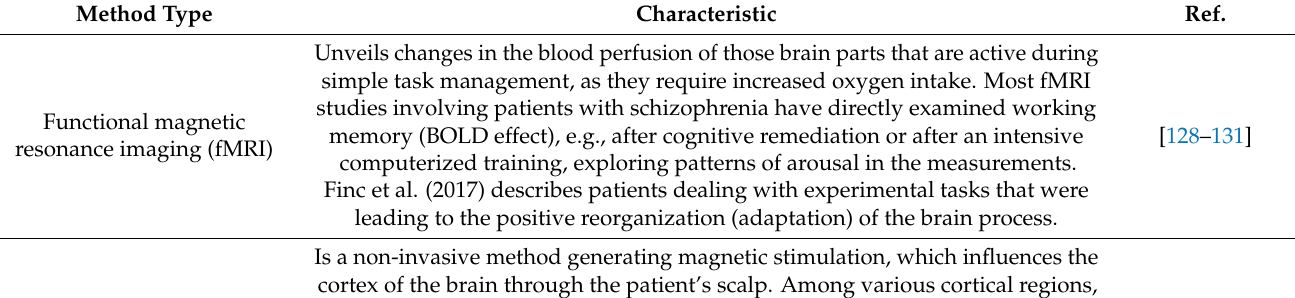
Table 1. Characteristics of methods supporting modulation in patients diagnosed with schizophrenia. Method